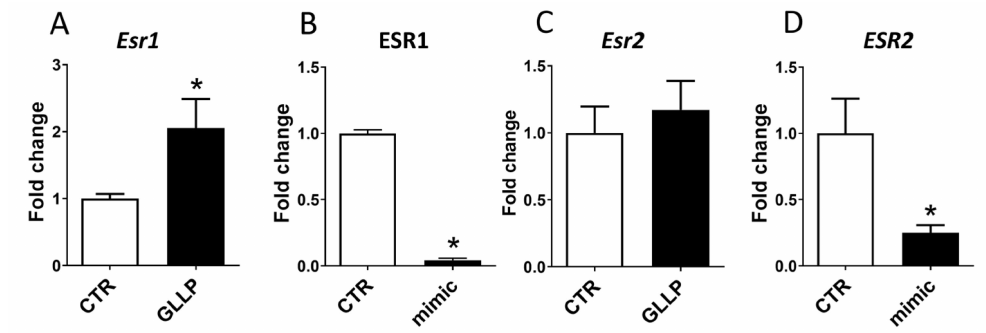
Figure 6. Esr1 ( A ) and Esr2 ( C ) gene expression profiles in the offspring VP from the CTR and GLLP groups at PND 540. Esr1 ( B ) and Esr2 ( D ) gene expression profiles in the PNT-2 human prostate cells from CTR and transfected with mimic miR-18a-5p. Data are expressed as mean ± SD. * means a statistical difference between experimental groups with p <